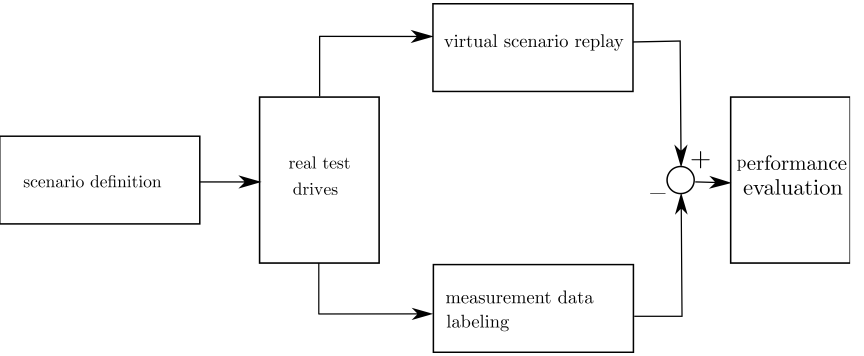
Figure 1. Dynamic ground truth sensor model validation